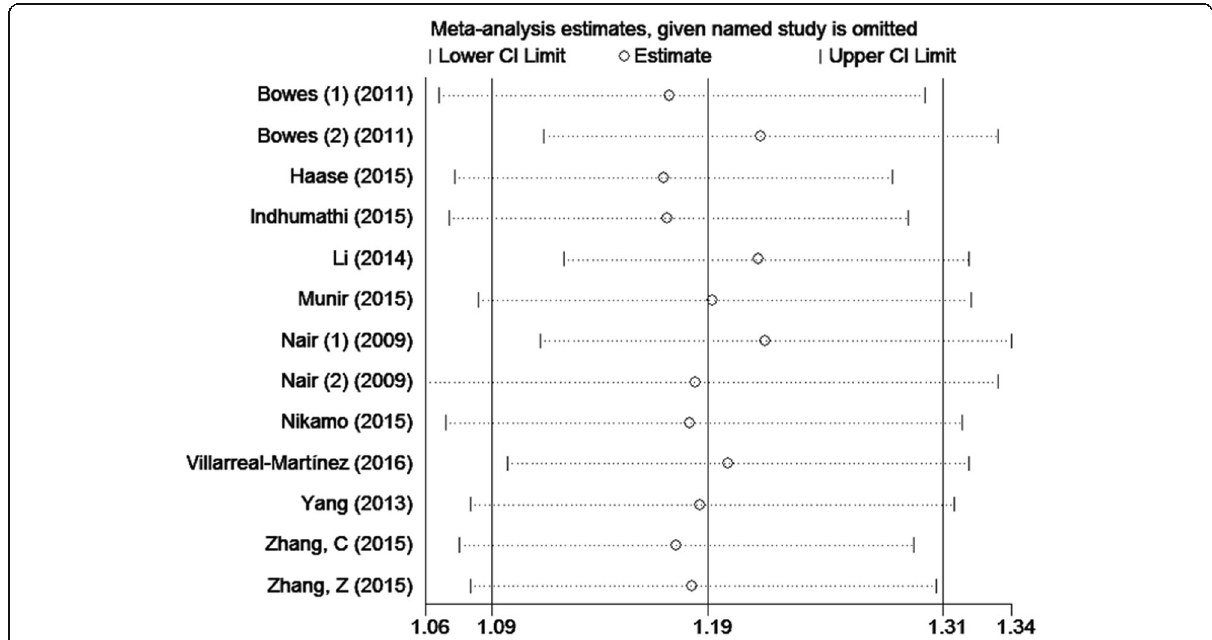
Fig. 5 Sensitivity analysis of rs610604 in TNFAIP3 gene and risk of psoriasis